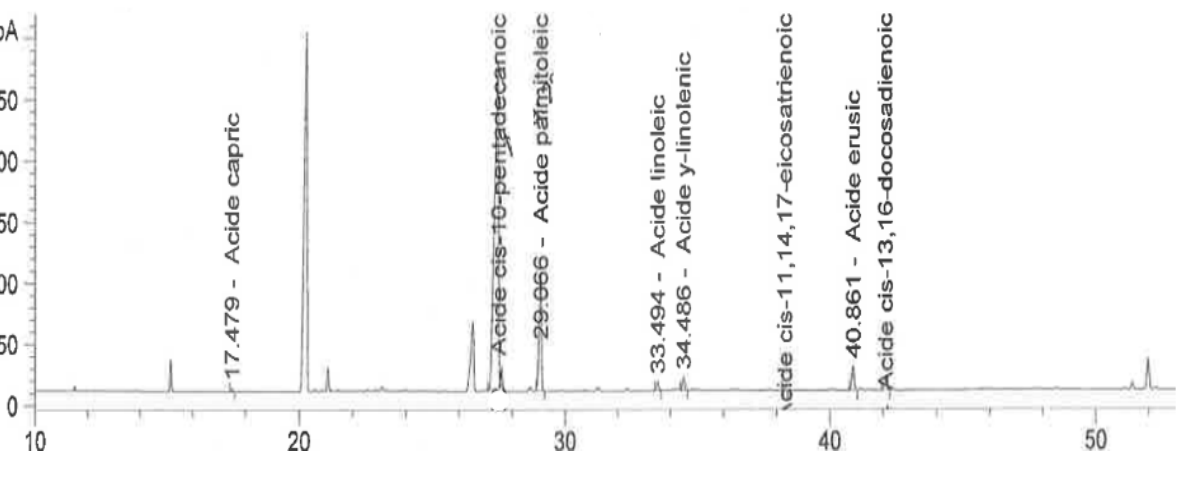
Figure 2. Chromatogram of fatty acid samples (G197).